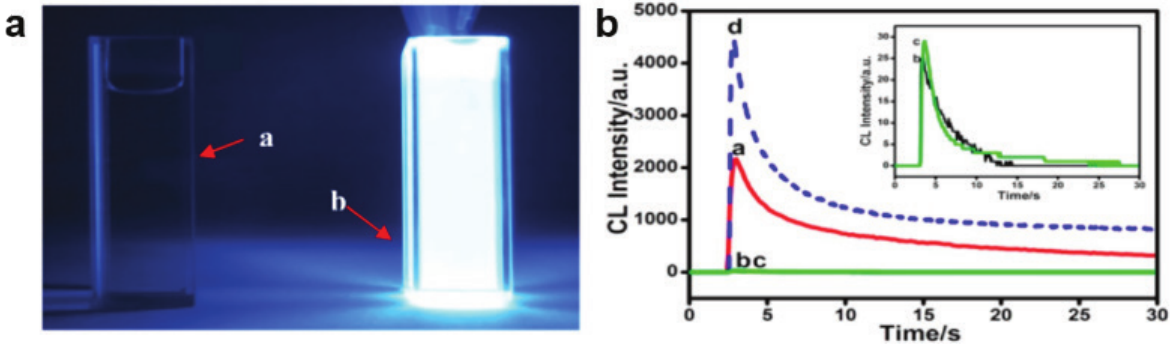
O without and with haemin@HKUST (left and right, respectively); (b) Chemiluminescence Figure 17: (a) Luminol in solution containing H 2 2 intensity observed in the presence of haemin@HKUST (red), with no catalyst (black), Cu-HKUST-1 (green) and free haemin (blue) [123]. Reprinted with permission from Ref. [123]. Copyright © 2015, American Chemical